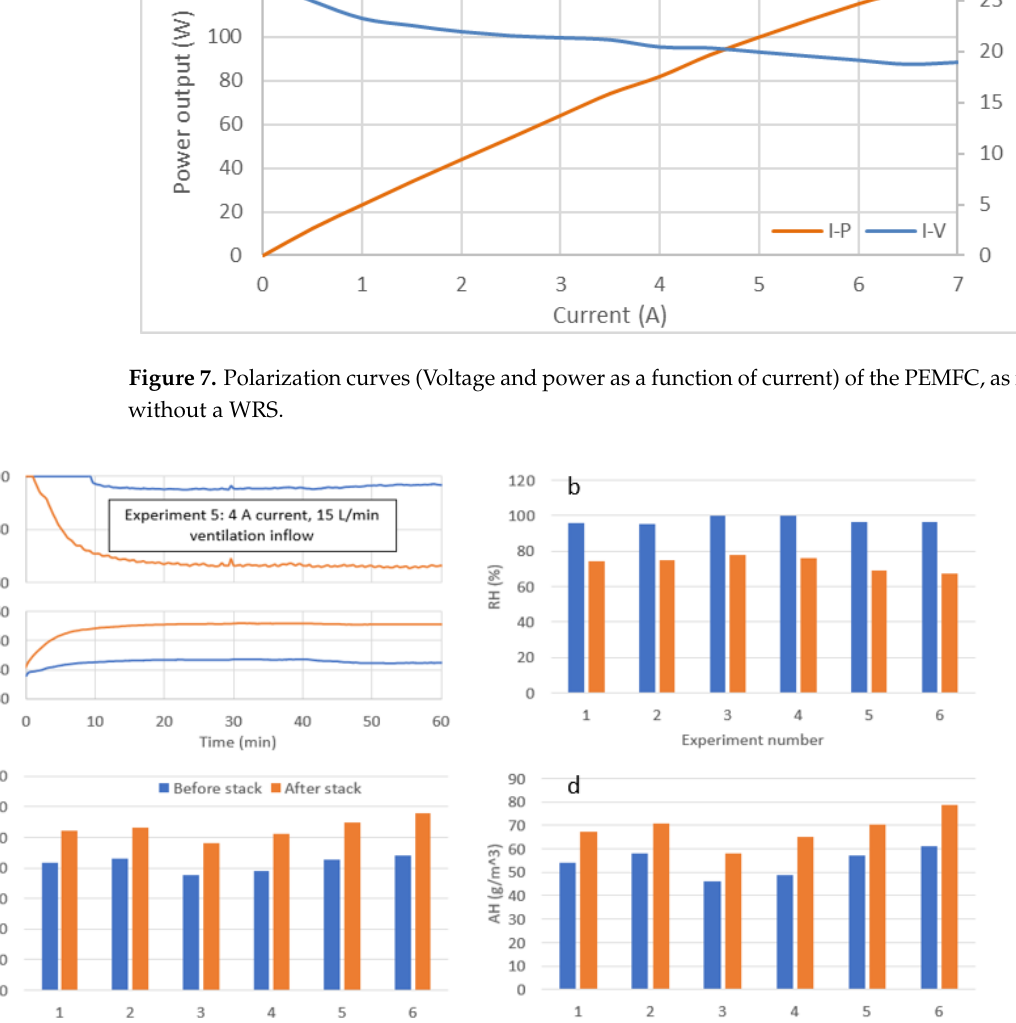
Figure 9. The measured power as a function of time for the different cases with varying currents and ventilation flow rates.